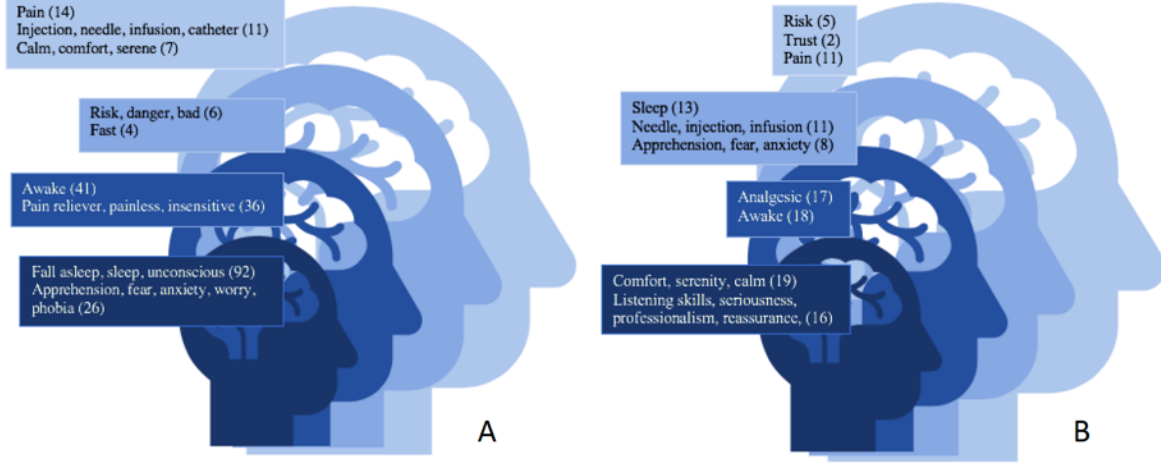
Figure 5. Graphic representation of patients' feelings before (A) and after (B) receiving information using the Abric method of hierarchized evocation. From the center to the periphery are spread out: the central core area, the first periphery, the contrasting elements, and the second periphery. The number of occurrences of the terms is indicated in